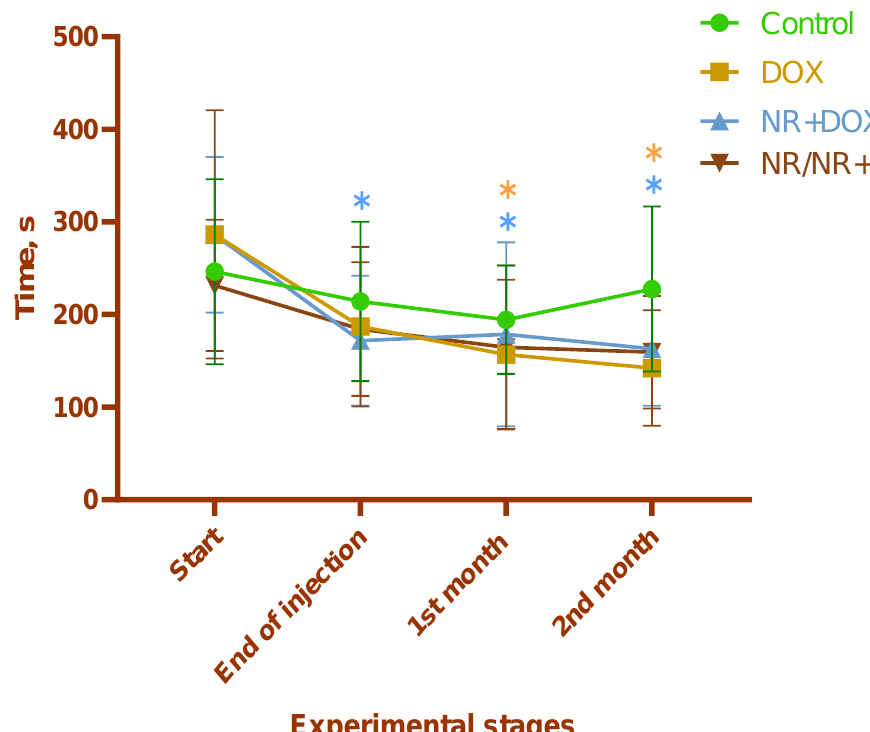
Figure 2. Treadmill activity duration. */*— p < 0.05 compared to the initial value (start of the experiment) (*—DOX; *—NR+DOX). Data are presented as median [25%; 75%]. Control represents control group (n = 15); DOX represents doxorubicin group (n = 15); NR+DOX represents nicotinamide riboside + doxorubicin group— combined mode (n = 15); and NR/NR+DOX represents nicotinamide riboside/nicotinamide riboside + doxorubicin group— preventive mode (n = 15). Table 1. Changes in the physical activity of animals as a percentage of the initial value. Start End of Injection 1st Month 2nd Month Control 100% DOX 69% 100% 80% 71% 69% DOX represents doxorubicin; NR represents nicotinamide riboside. *— p < 0.05, significant difference compared to the initial value (start of the experiment). Control represents control group (n = 15); DOX represents doxorubicin group (n = 15); NR+DOX represents nicotinamide riboside + doxorubicin group— combined mode (n = 15); and NR/NR+DOX represents nicotinamide riboside/nicotinamide riboside + doxorubicin group— preventive mode (n = 15).